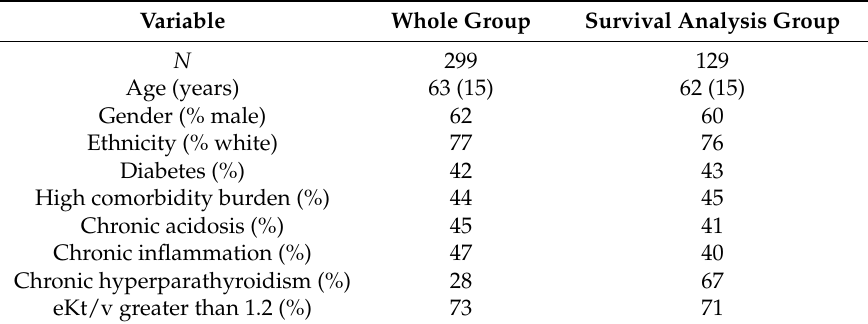
Table 1. Characteristics of those patients involved in the analysis.